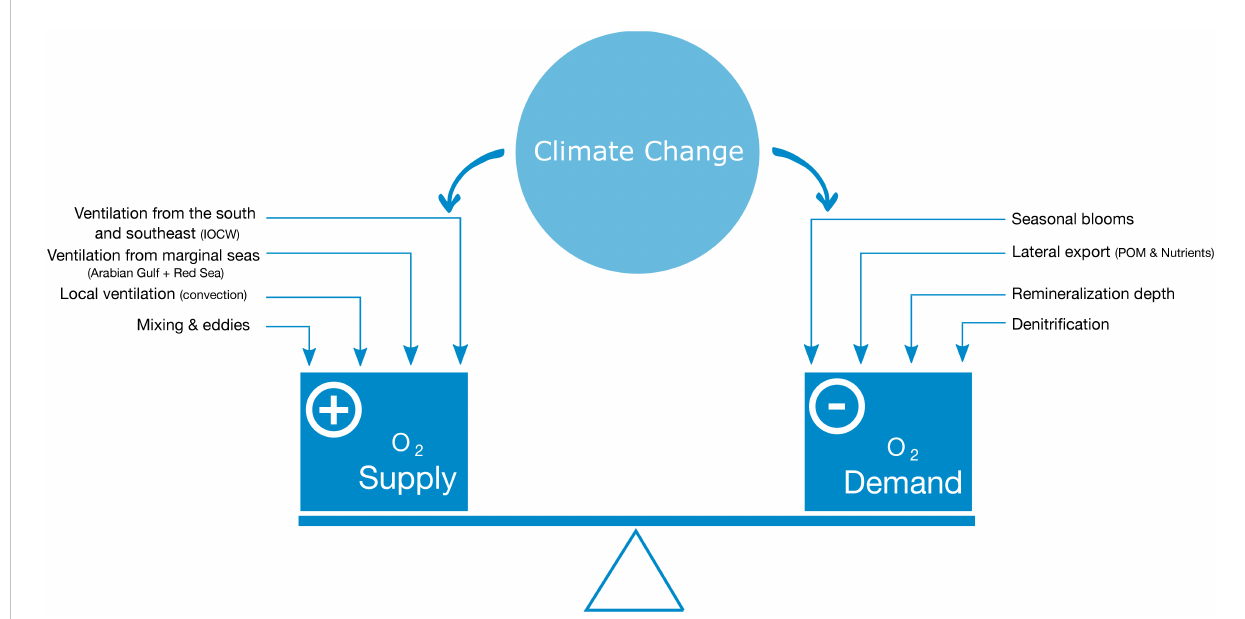
FIGURE 1 Factors controlling the Arabian Sea OMZ intensity. Main factors controlling the O 2 supply (left pan of the balance) and demand (right pan of the balance) under the in fl uence of climate change that may offset the balance, favoring deoxygenation or